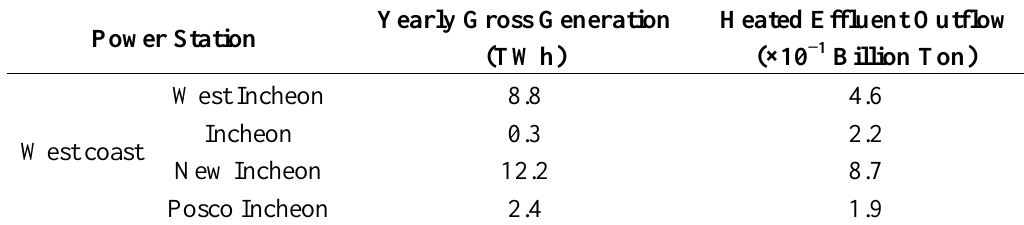
Table 3. Yearly gross power generation and hot waste water outflow in